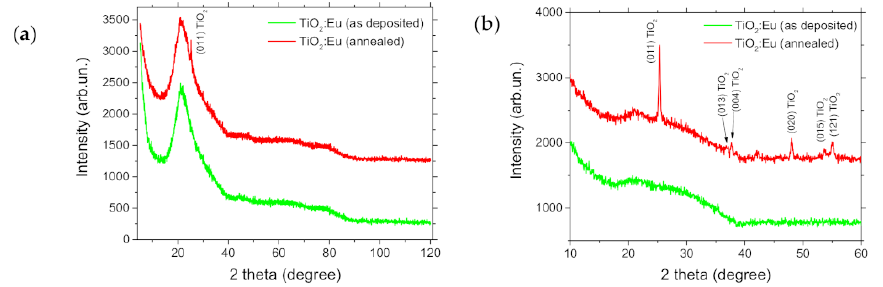
Figure 9. XRD patterns of TiO 2 :Eu thin film (as deposited and after PLA processing, 400 shots), ( a ) 2theta-omega and ( b ) grazing incidence